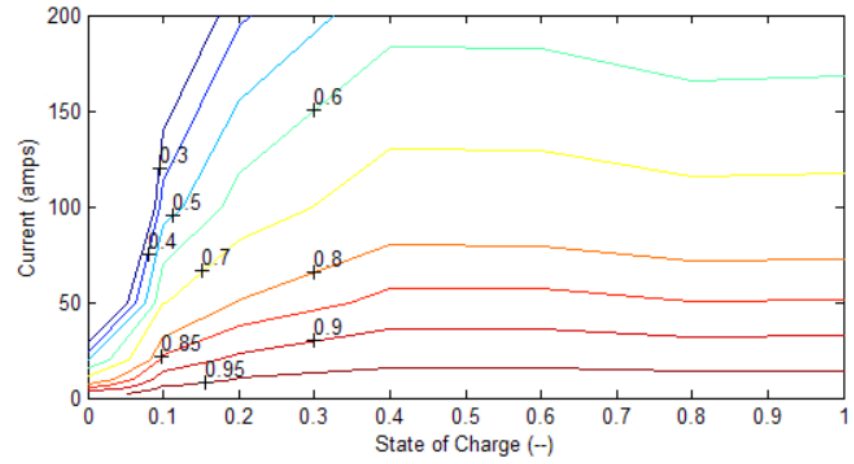
Figure 4. Battery current diagram.